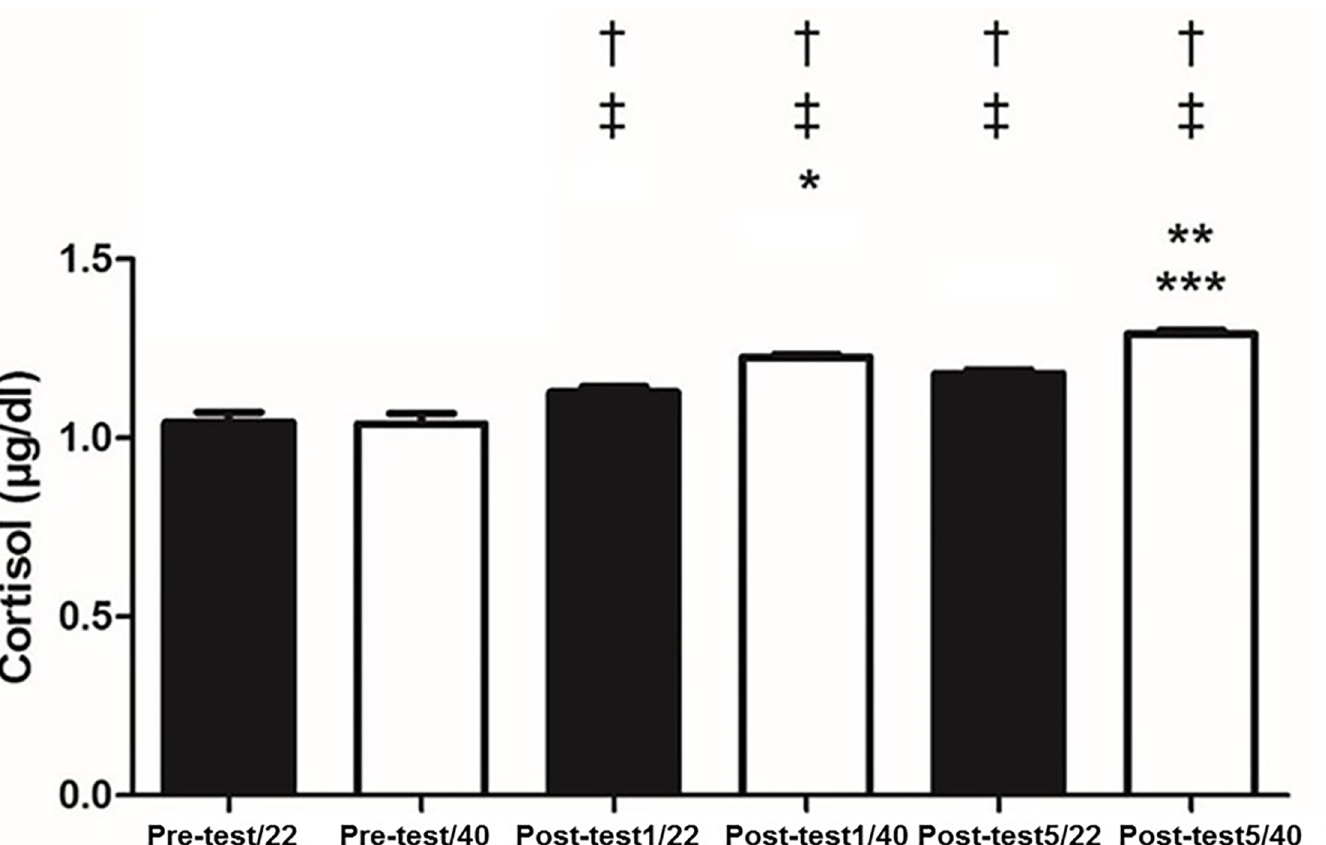
Fig 2. Salivary concentrations of cortisol pre-test and at one (Post-test1) and five minutes (Post-test5) after physical exhaustion at temperatures of 22 and 40˚C. † p < 0.05 different from Pre-test/22; ‡ p < 0.05 different from Pre-test/40; � p < 0.05 different from Post-test1/22; �� p < 0.05 different from Post-test1/40; ��� p < 0.05 different from